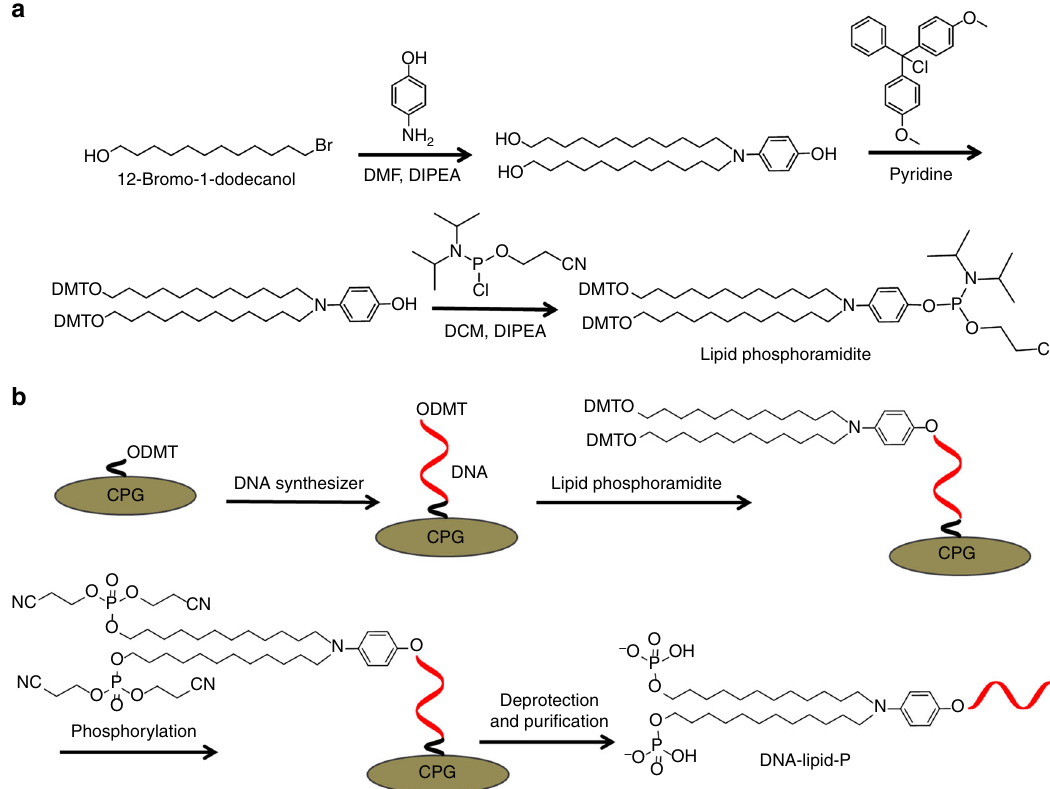
Fig. 3 Synthesis of lipid phosphoramidite and DNA-lipid-P. a Synthesis route of lipid phosphoramidite. DMF indicates N,N-dimethylformamide. DIPEA indicates N,N-diisopropylethylamine. DCM indicates dichloromethane. b DNA synthesis route of DNA-lipid-P. Chemical phosphorylation was performed by coupling bis(2-cyanoethyl)-N,N-diisopropylphosphoramidite with oligonucleotide on a DNA synthesizer. CPG indicates controlled pore